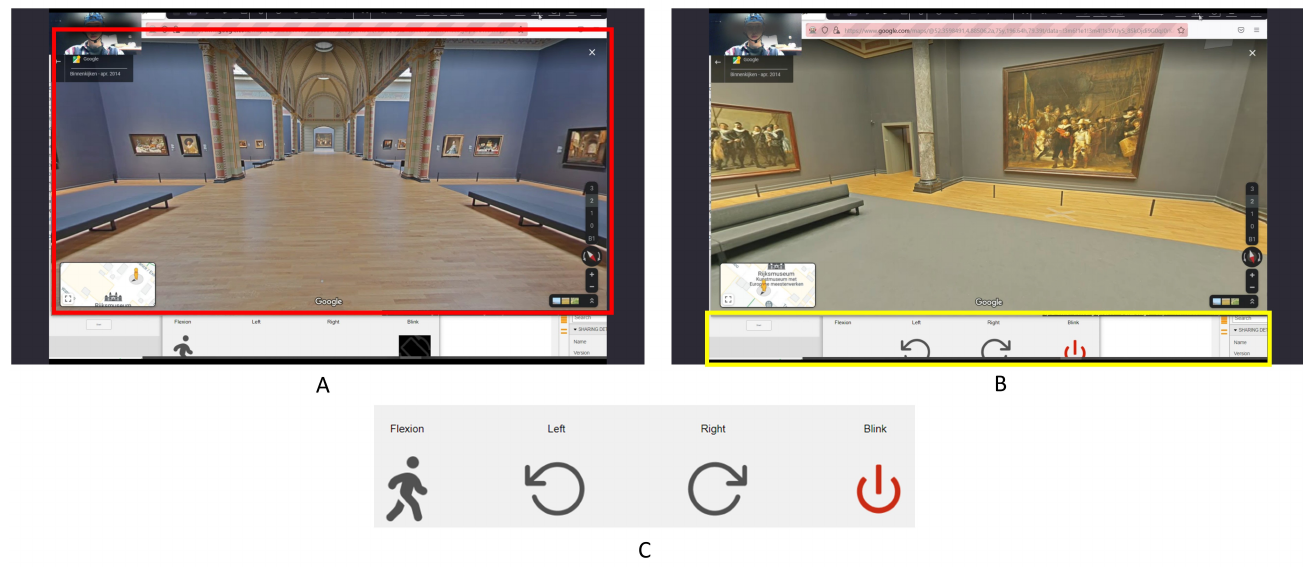
Figure 6. Navigation interface. Panel A: the main navigation window, Panel B: the state bar, Panel C: the four navigation actions.